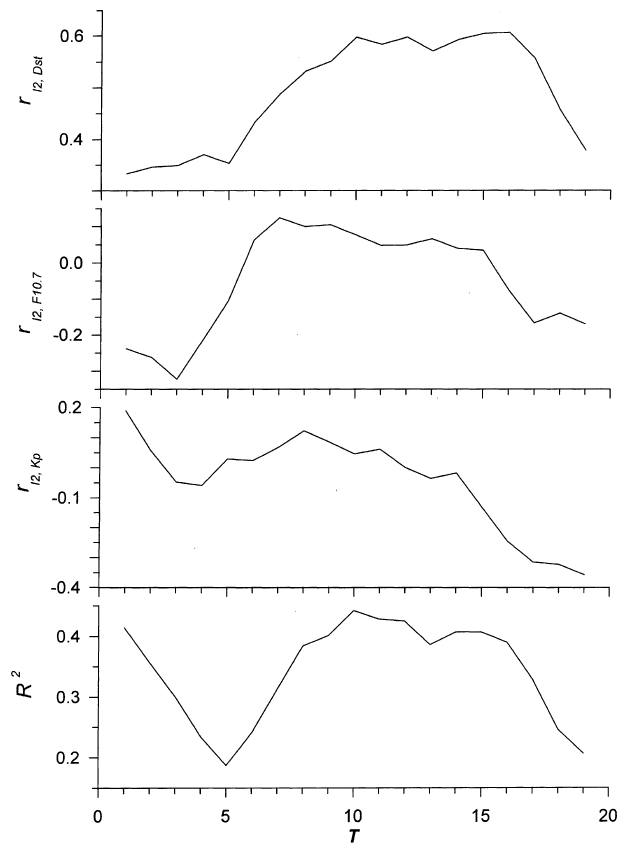
Fig. 7. Dependence of the partial correlation